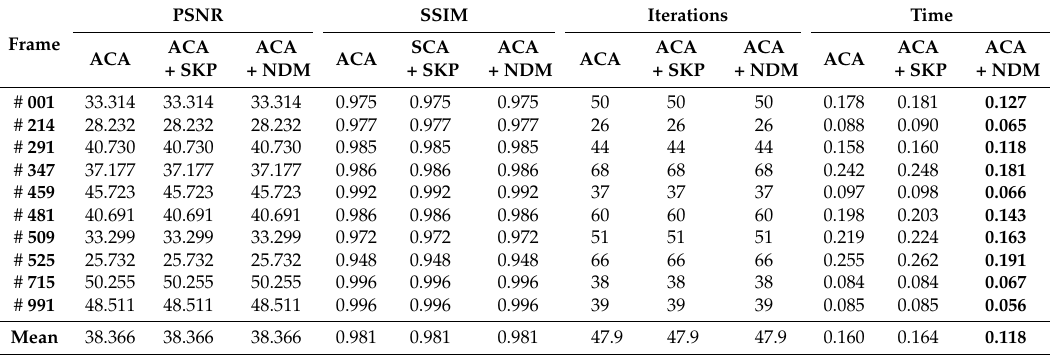
Table 5. Quantitative evaluation results for comparing internal algorithms of the proposed method on the selected Tsukuba Stereo Dataset. The best performance is highlighted in bold. ACA, asynchronous cellular